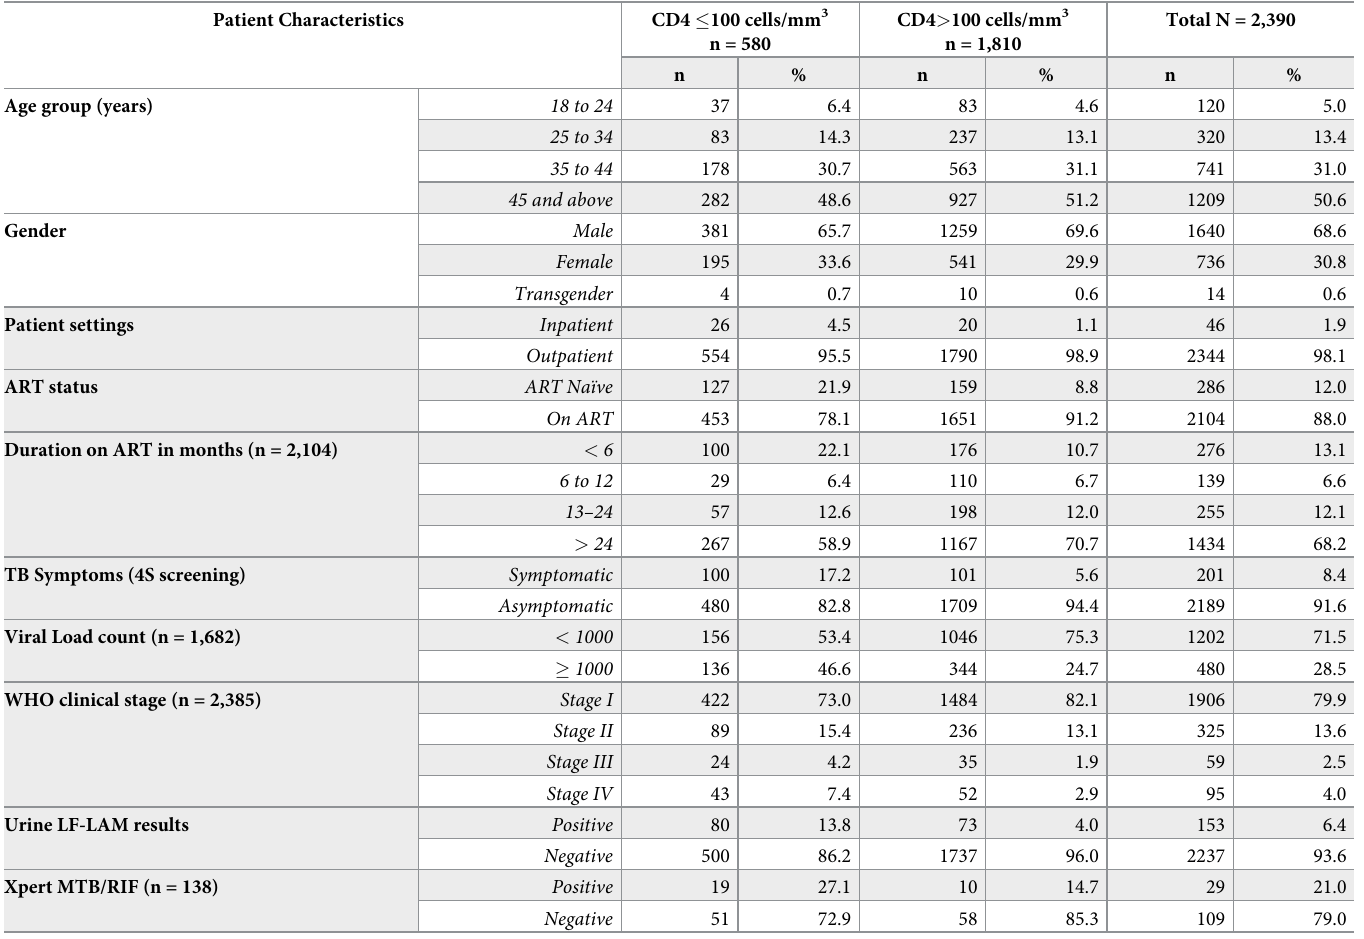
Table 1. Distribution of demographic, clinical and treatment characteristics by CD4 count. Patient